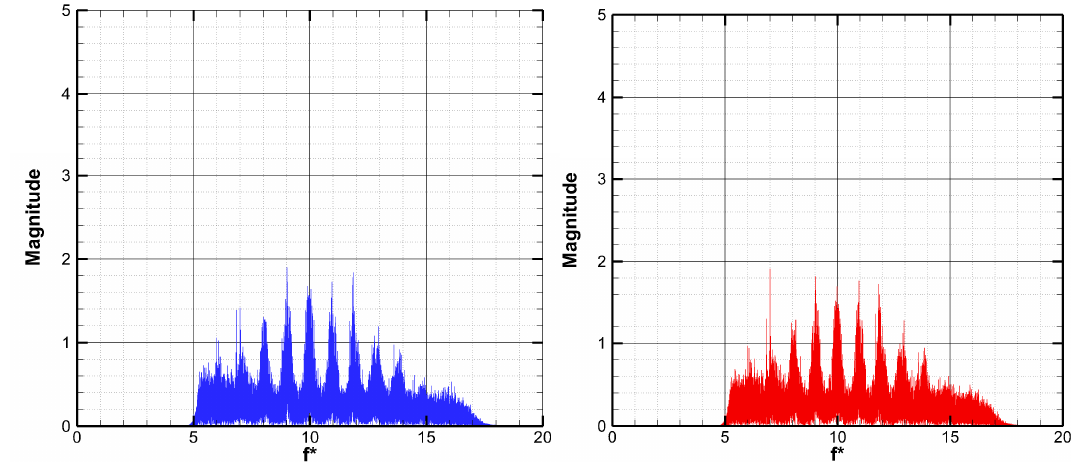
Figure 7. Butterworth bandpass-filtered pressure signals Transducer 1 ( left , blue) and Transducer 2 ( right , red).